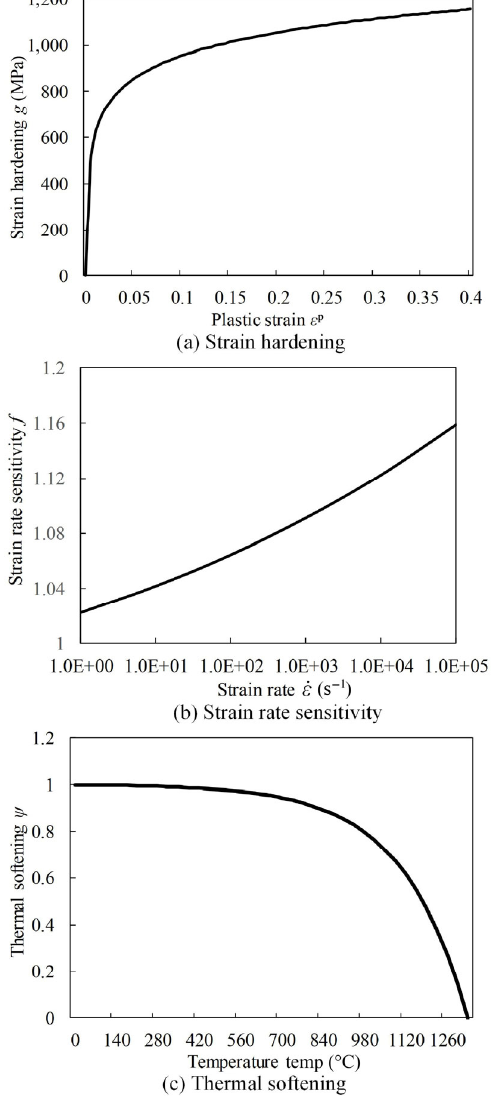
Fig. 3 (a) Strain hardening, (b) strain rate sensitivity, and (c) thermal softening for U71Mn.